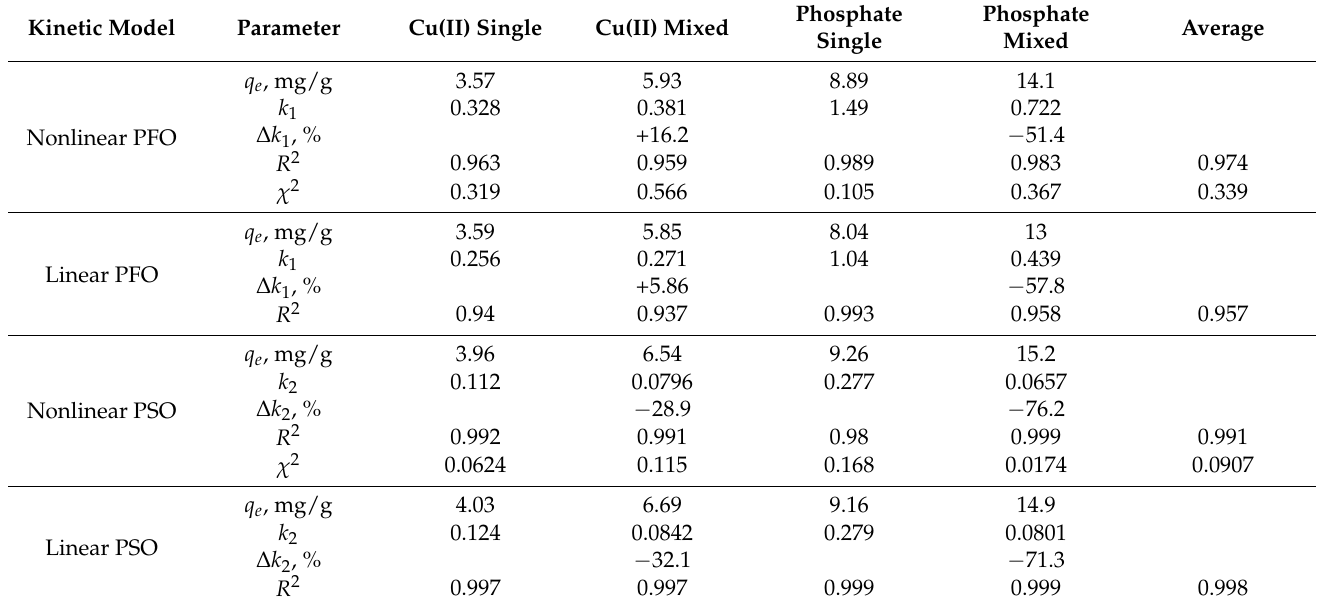
Table 3. Parameters calculated from linear and nonlinear PFO and PSO models under single and mixed conditions.